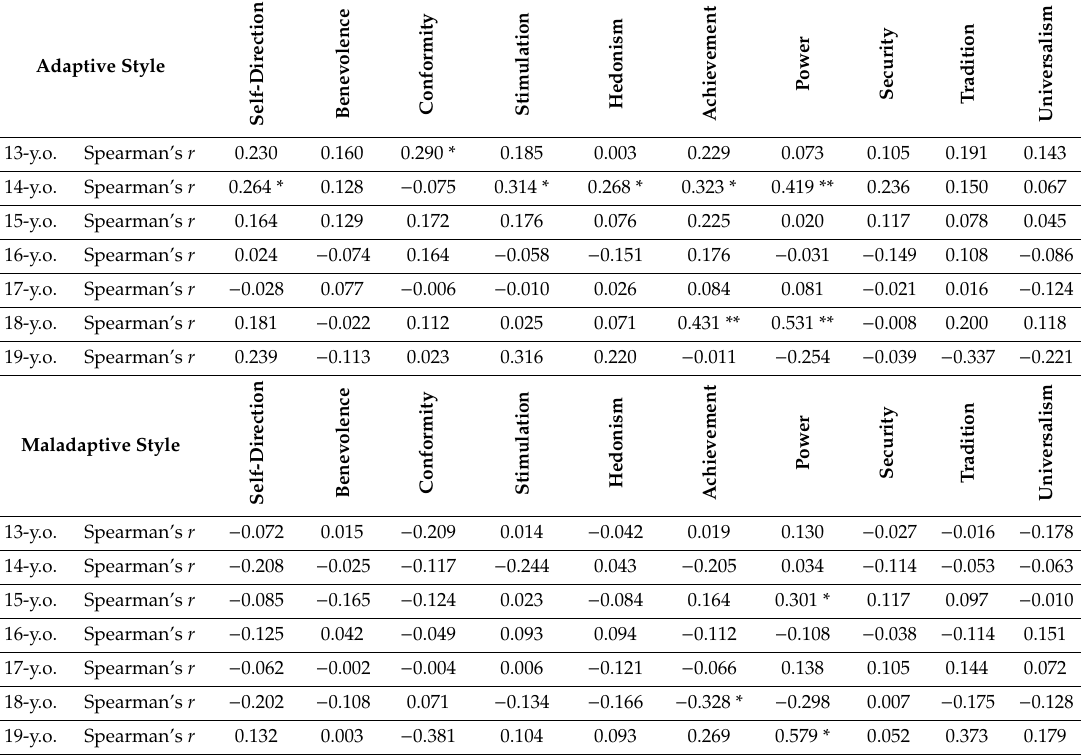
Table 4. Correlation between decision-making styles and value categories based on